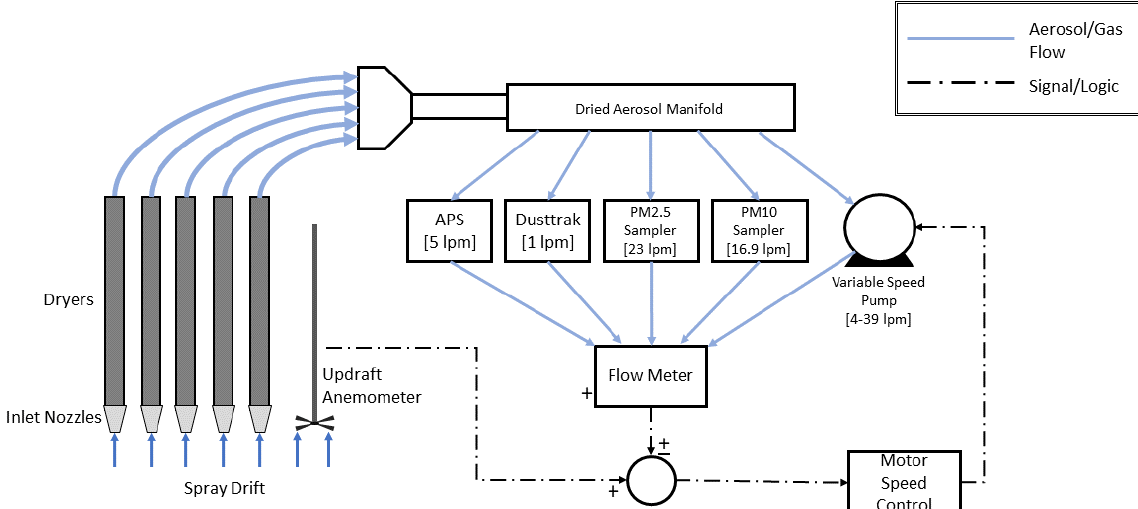
Figure 3. Feedback control for matching vertical updraft velocity.